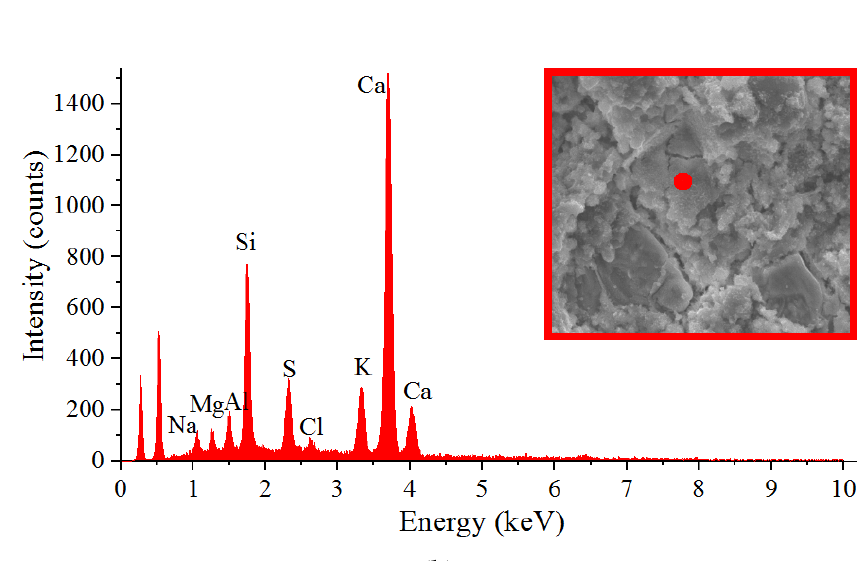
( b ) Figure 7. C/S ratio for analyzed samples: ( a ) without FA—relationship between 0FA4NA and 0FA0NA, ( b ) including FA— relationship between 20FA4NA and 20FA0NA. Figure 6 shows example EDS spectra for the structures of composites with FA, con- taining the active NA (Figure 6b) and produced without it (Figure 6a), after 8 h of curing. Figure 7 shows the comparison of the C/S ratio for the samples produced only with the cementitious binder (Figure 7a) as well as those containing 20% FA (Figure 7b) in all of the analyzed time periods. By analyzing the SEM images and SEM–EDS spectra of the samples at successive periods, the formation of successive hydration products was evident. These products could be seen in the form of crystalline phases and the formation of portlandite plates (which are a product of allite hydration). The use of the NA (nanometric seeds of the CSH phase in liquid form) significantly contributed to the formation of more silicate gel (C-S- H) responsible for the strength of the cement matrix.